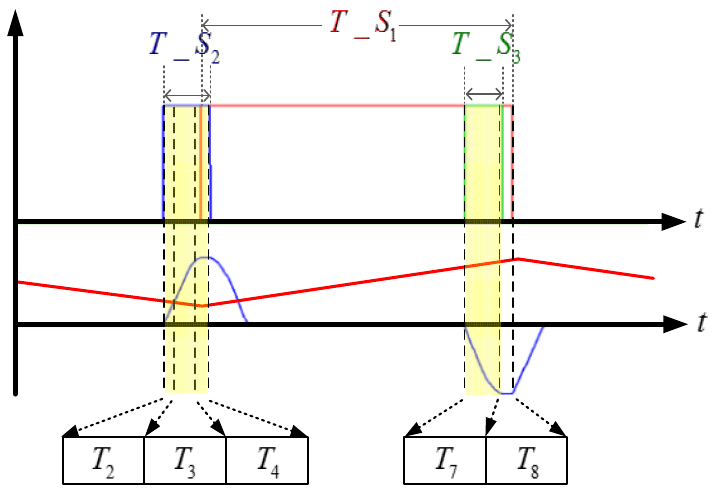
Figure 14. Pulse width modulation (PWM) signals of the main and auxiliary switch.